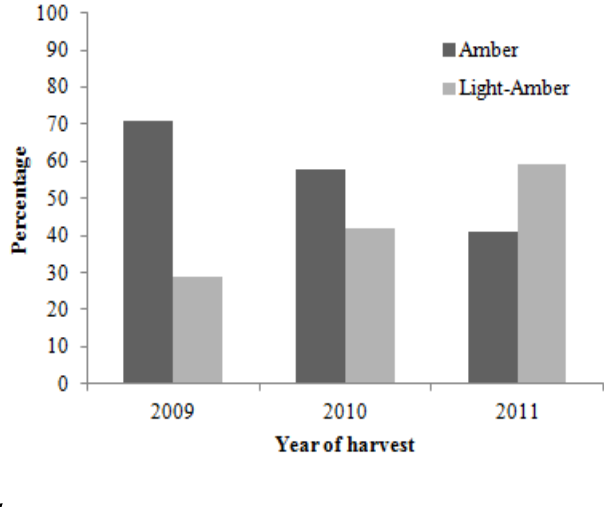
Figure 2. Colour of the samples in each